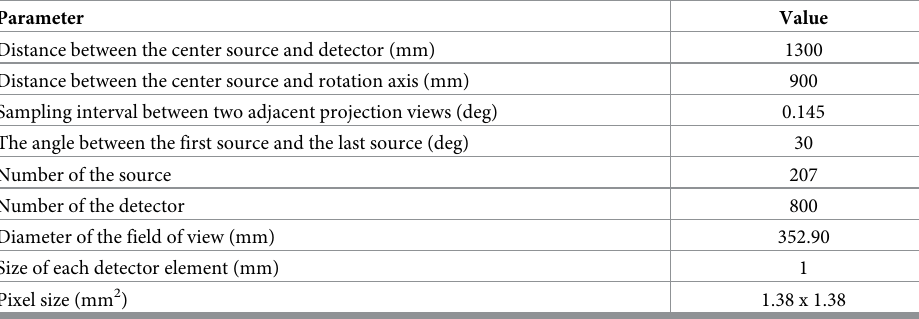
Table 1. Geometrical scanning parameters of simulated TCT system. Parameter Value Distance between the center source and detector (mm) 1300 Distance between the center source and rotation axis (mm) 900 Sampling interval between two adjacent projection views (deg) 0.145 The angle between the first source and the last source (deg) 30 Number of the source 207 Number of the detector 800 Diameter of the field of view (mm) 352.90 Size of each detector element (mm) Pixel size (mm 2